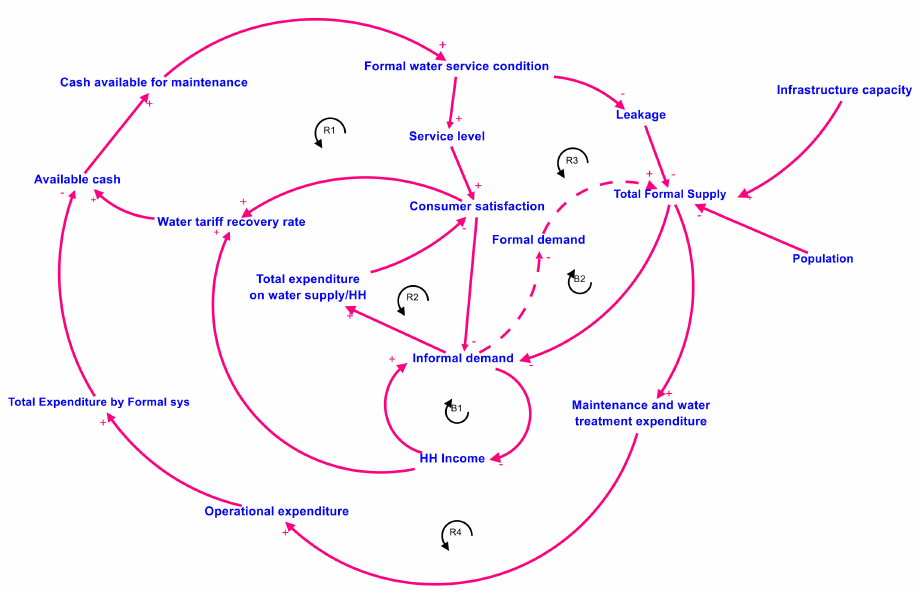
Figure 1. Feedback processes in formal–informal supply